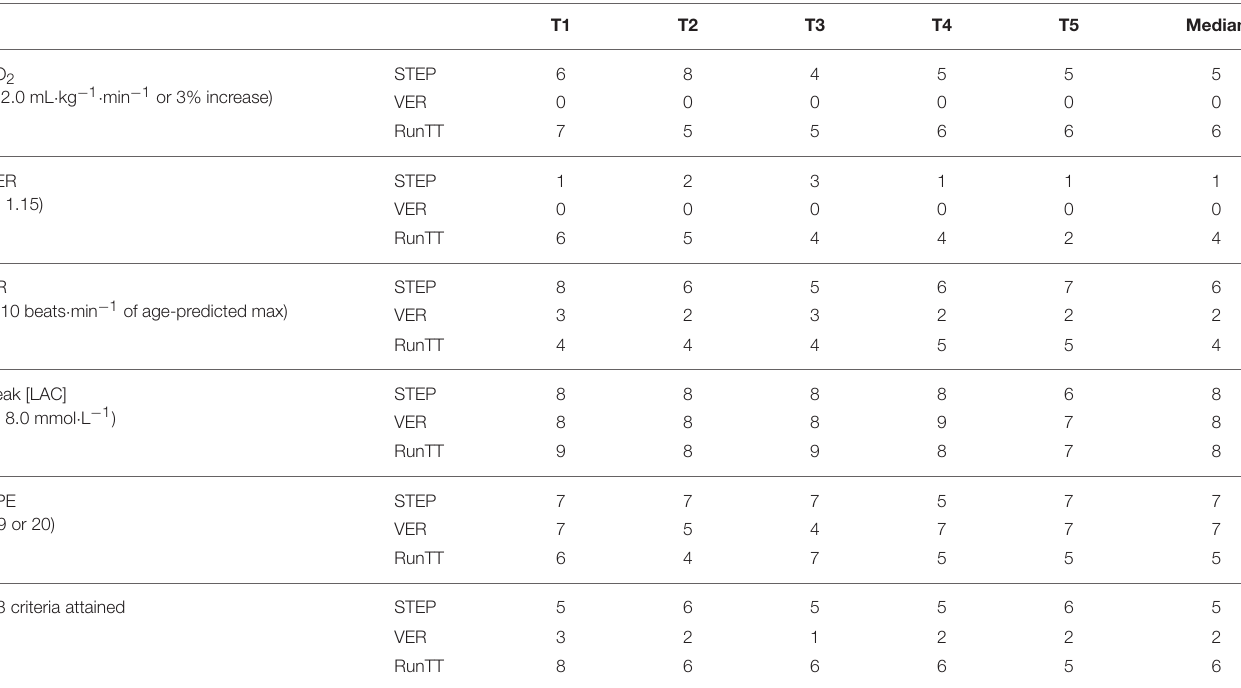
TABLE 1 | The number of participants (out of 10) who fulfilled the criteria for attaining ˙ VO 2 max during the five STEP, VER, and RunTT trials (T1–T5). T1